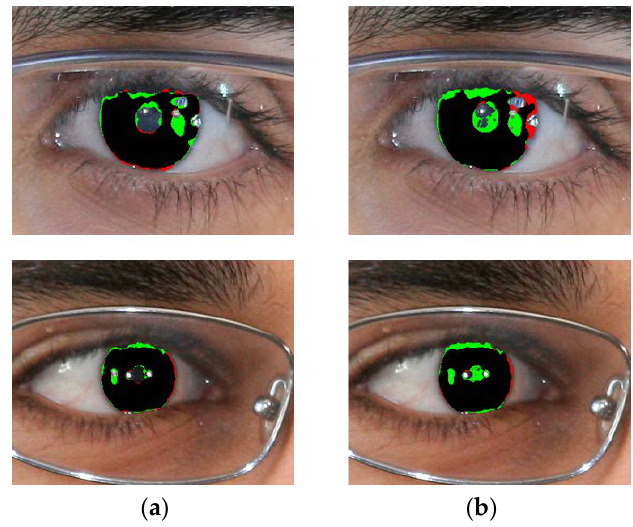
Figure 22. Comparisons of pupil boundary detection. Segmentation results obtained by ( a ) IrisDenseNet and ( b ) SegNet.